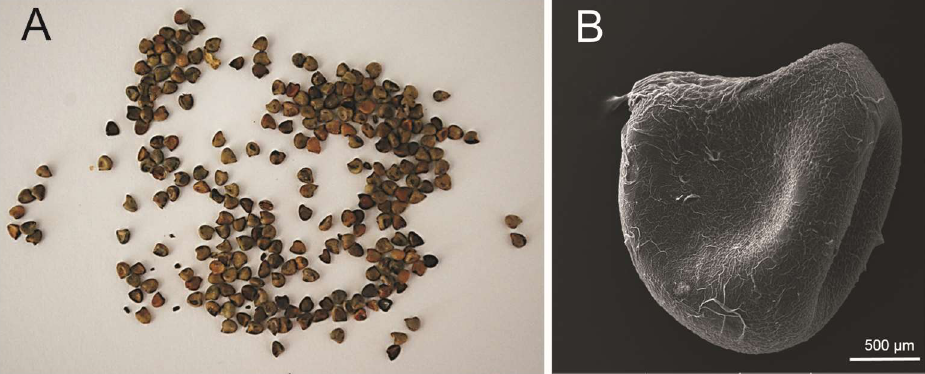
Figure 1. S. hermaphrodita seeds: ( A )—macroscopic image; ( B )—microscopic image obtained with a scanning electron microscope (SEM).